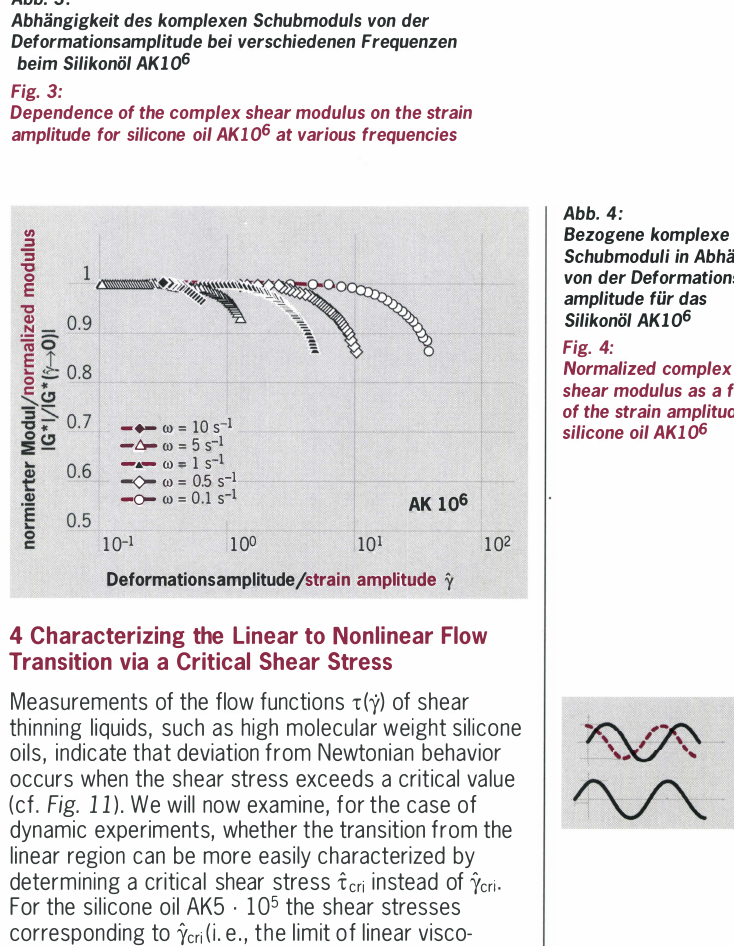
In a log-log plot of G*